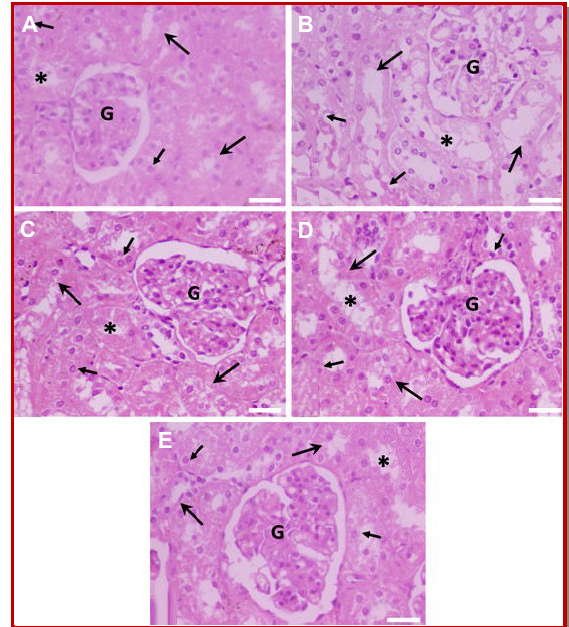
Figure 2: Histopathological evaluation of B. baluchistanica on GM-induced nephrotoxicity (H and E staining; x40, scale bar =100 μ m) (n = 6 rabbits per group). (A): Photomicrograph of a section of kidneys from a rabbit treated with normal saline/ vehicle showing normal appearance of glomerulus (G) in a Bowman’s capsule interspersed among renal tubules (large arrows) lined by epithelial cells (small arrows) with a brush border extending into the lumen (asterisk). (B): Photomicro- graph of a section of kidney from a rabbit treated with Gen- tamicin (100 mg/kg) showing mild atrophy of glomerulus (G), inflammation of interstitial spaces, dilatation of renal tubules (large arrows) containing cellular cast (small arrows) in their lumen (asterisk). Normal histological appearance of glomerulus (G), renal tubules (large arrows) lined by epitheli- al cells (small arrows) with a brush border extending into the lumen (asterisk) are observed in groups of rabbits treated with (C): mBBE (100 mg/kg) plus GM, (D): mBBE (200 mg/ kg) plus GM, and (E ): mBBE (300 mg/kg) plus